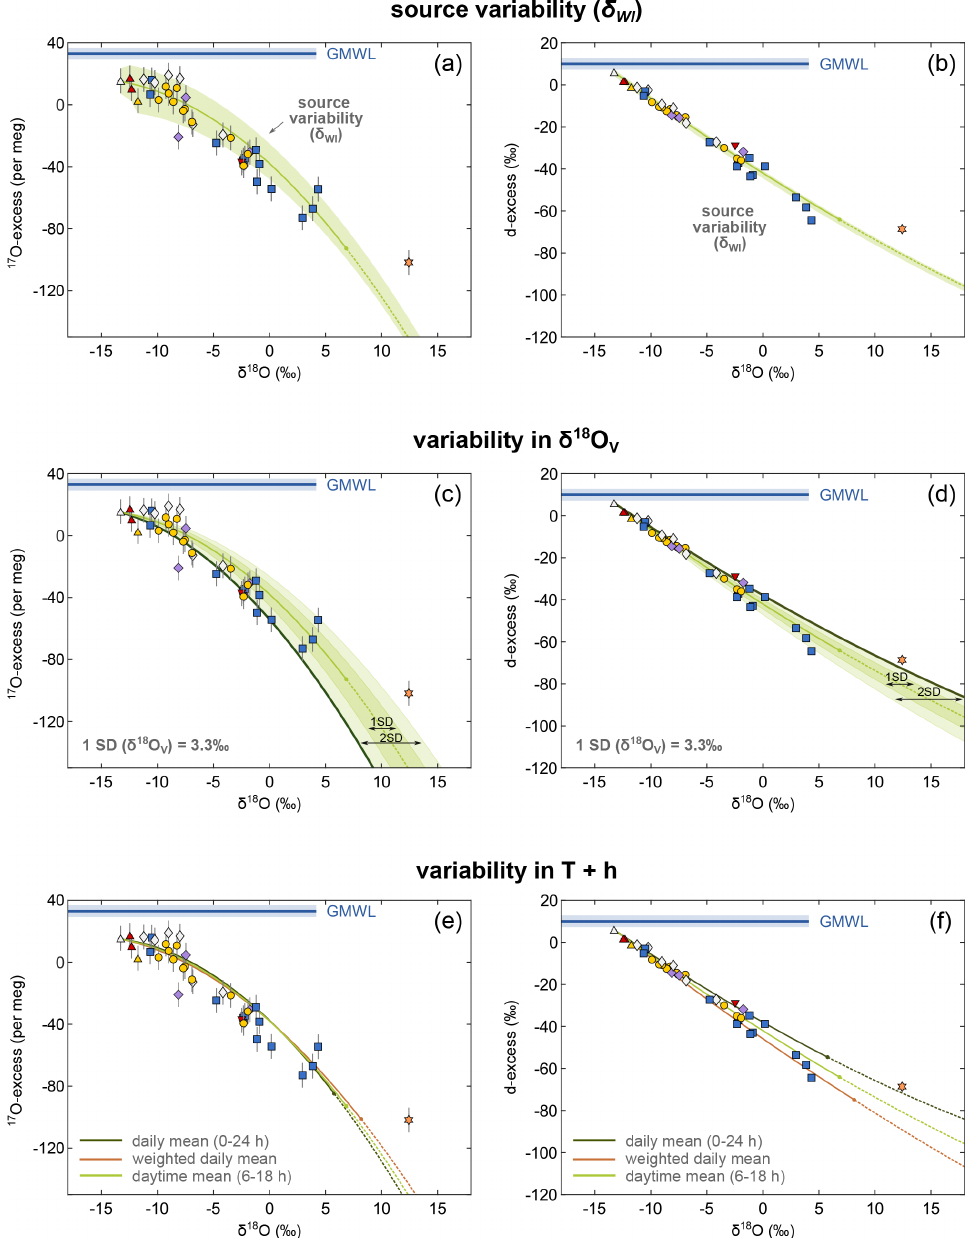
Figure 11. Illustration of the impact of variability and uncertainty in the model input parameters on the evaporation trajectory exemplified for lakes and ponds sampled in September 2017. The green line shows the modelled recharge evaporation trajectory for mean daytime conditions (06:00–18:00CLT) at the Salar del Huasco. The shaded green areas in (a) and (b) illustrate the uncertainty introduced to the modelled trajectory by spatial variability in the isotopic composition of inflowing water ( δ WI ). Panels (c) and (d) show the impact of variable δ 18 O V on the evaporation trajectory illustrated by multiples intervals of the SD (1SD = 3.3‰; shaded areas). The dark solid lines represent corresponding evaporation trajectories in (c) and (d) . Panels (e) and (f) illustrate the effect of uncertainty in the assumed effective evaporation time interval. Recharge evaporation trajectories have been modelled for (1) daily mean (00:00–24:00CLT; h = 33%, T = 4 ◦ C) (dark green curve), (2) daily mean h = 20% and T = 10 ◦ C weighted for the average diurnal distribution of temperature and wind speed (brown curve), and (3) daytime mean (06:00–18:00CLT; h = 27%, T = 7 ◦ C) conditions (light green